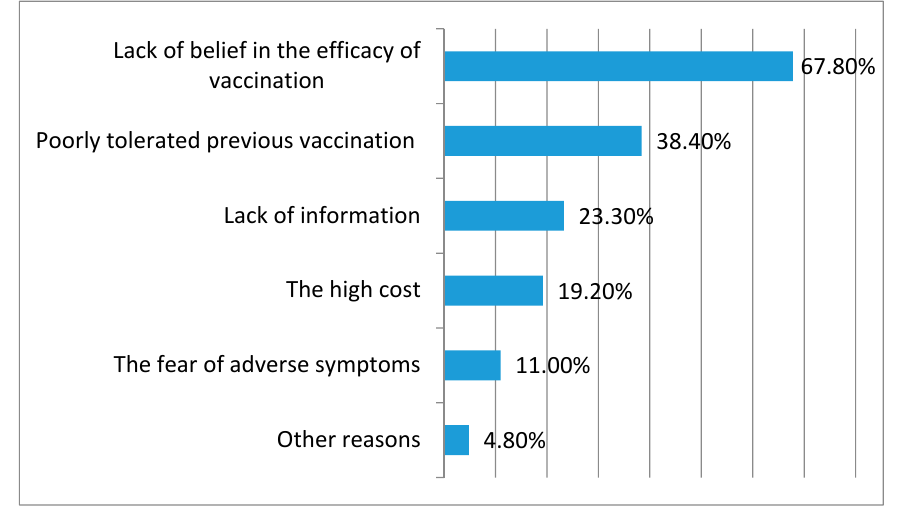
Figure 1. Reasons for not receiving the influenza vaccine among the elderly patients. Szczecin, Poland, 2015–2016; n = 230.